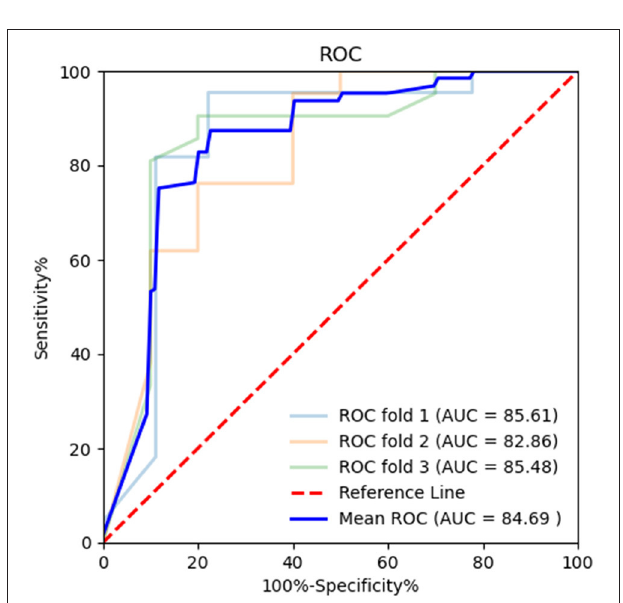
FIGURE 7 | Receiver operating characteristic (ROC) curve combining both the BR alternation rate and MoCA score in k-fold cross-validation. K-fold cross-validation was used to evaluate the predictive performance. The mean area under the curve (AUC) was 0.847, sensitivity 91.28%, and specificity